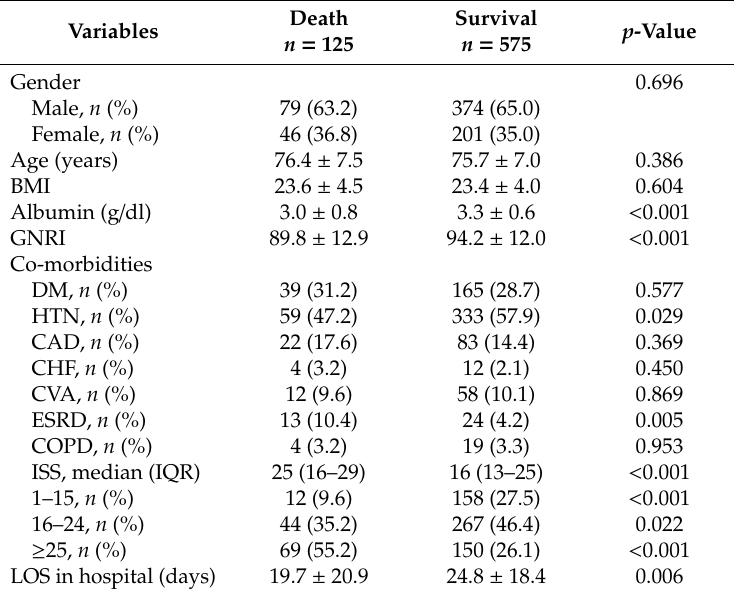
Table 1. Patient and injury characteristics of the mortality and survival groups of older trauma patients in the intensive care